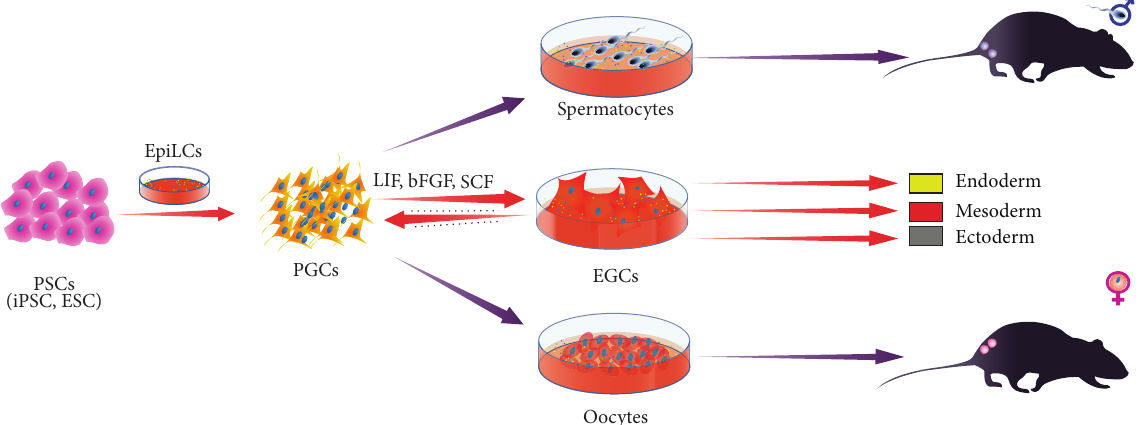
Figure 2: Making gametes from pluripotent stem cells (PSC). Primordial germ cells (PGCs), embryonic germ cells (EGCs).